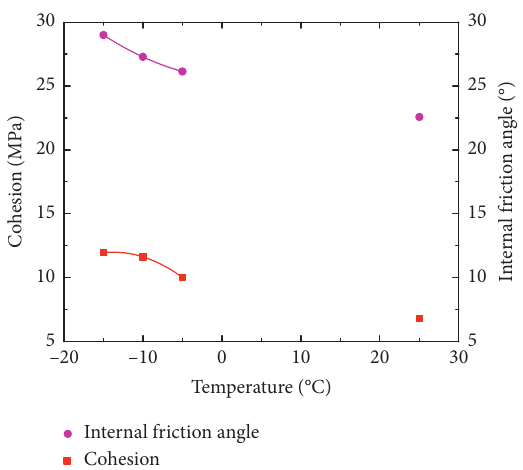
Figure 6: Cohesion and internal friction angle curves at different temperature.